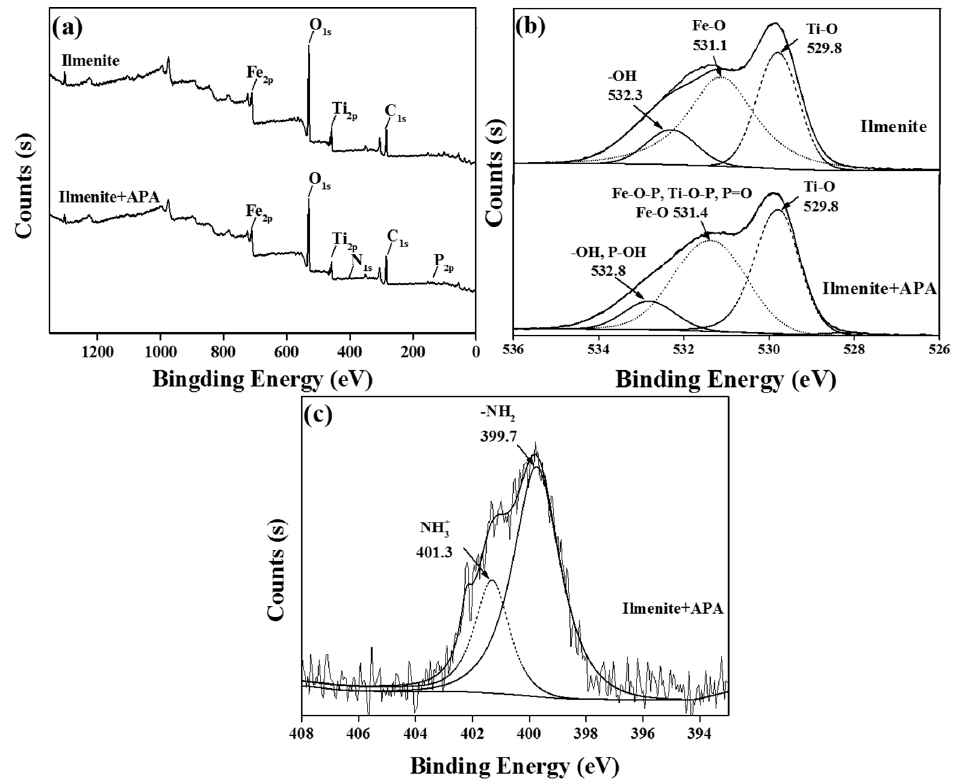
Table 3. Relative amounts of elements on the ilmenite surface.